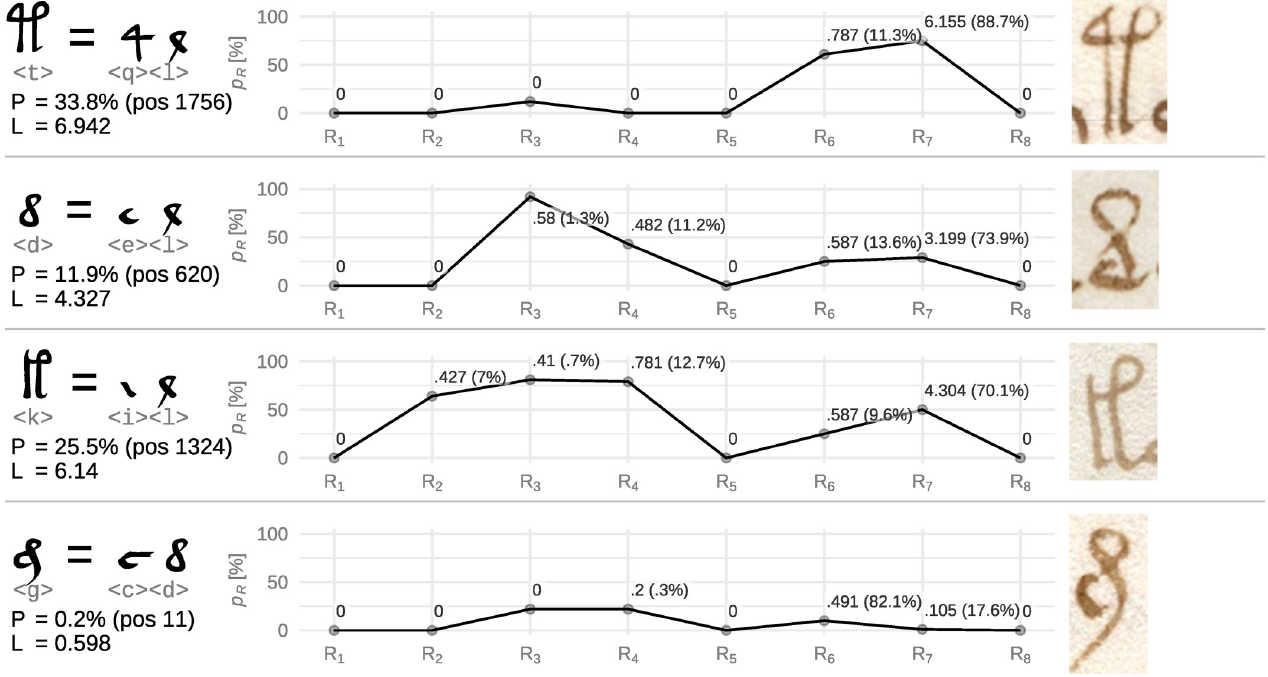
Fig 8. Loss scores of ligature candidates < t > , < d > , < k > , < g > . See Fig 6 for details. Symbol illustrations were taken from: f18v, f2r, f58v, f23v.